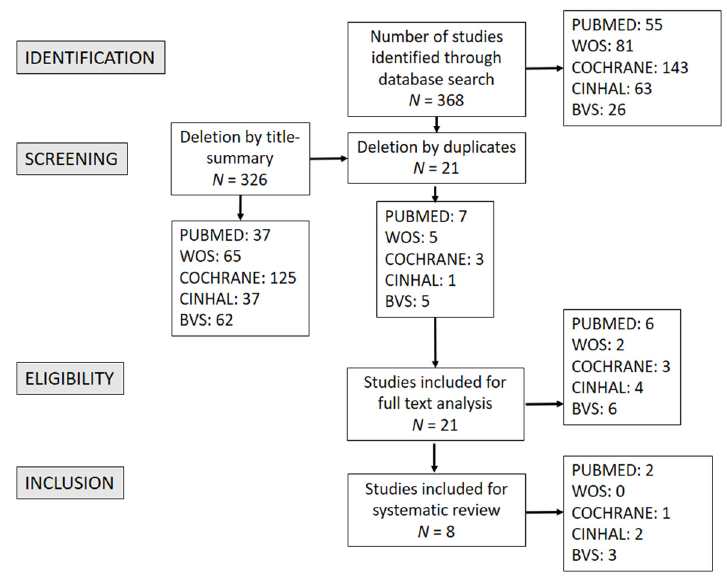
Figure 1. Prisma flow chart.